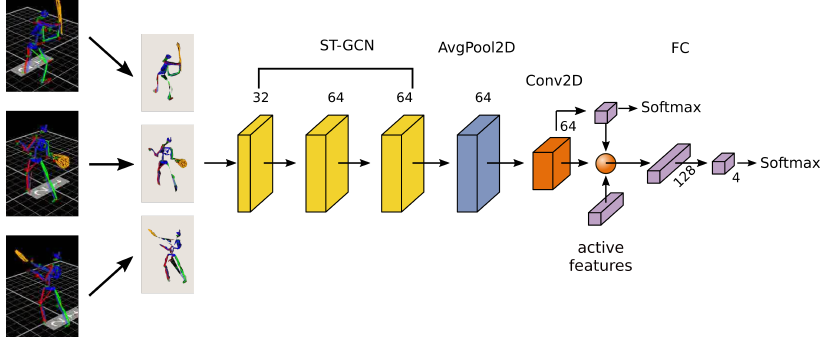
Figure 3. Scheme of used classifier consisting of the ST-GCN part and the active features knowledge